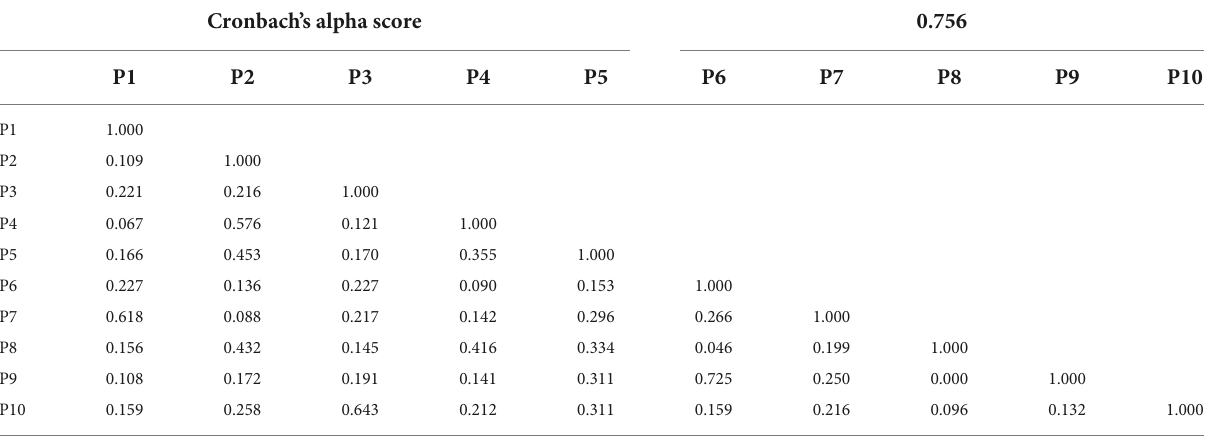
TABLE 9 Results of the reliability (internal consistency) analysis in the practices section of the validation